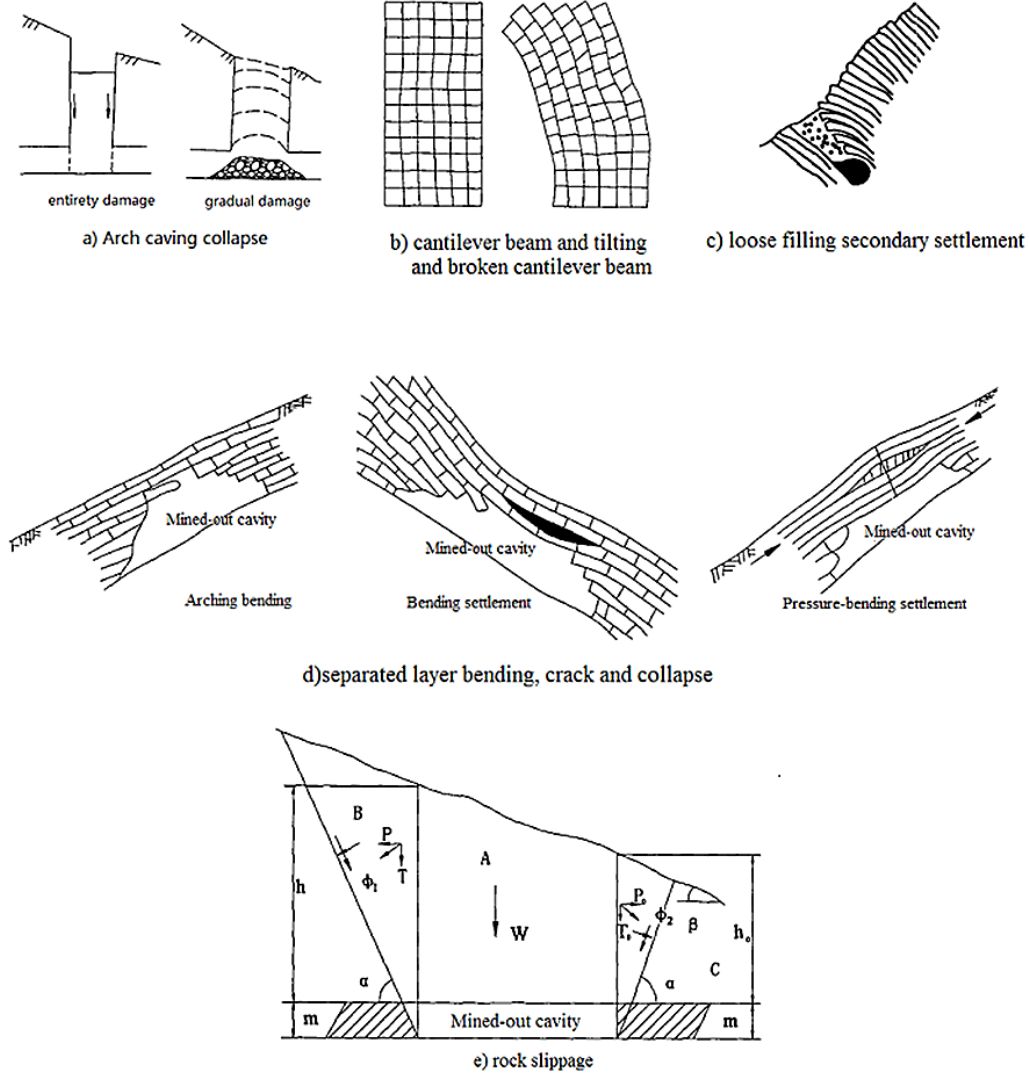
Figure 3. Land subsidence patterns in mined-out